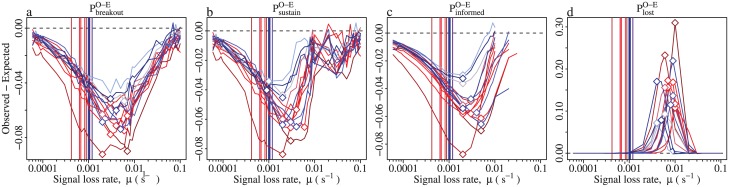
Transmission inhibition is maximal when the loss rate μ exceeds the activity cycle rate, γ.Each line gives the transmission characteristics for a single three-day contact network as a function of the loss rate μ. The transmission rate is held constant at β = 1. Coloured lines distinguish among different colonies. Vertical lines indicate the activity cycle rate for each network, γ = 1/λ. Diamonds indicate the maximum transmission reduction attained by each network. Panels show the difference between observed and expected values of (a) the mean probability that the information spreads beyone the initial seed, (b) the mean probability that the informed population reaches the steady state, (c) the mean size of the steady state population, and (d) the mean probability that the informed population declines to zero.